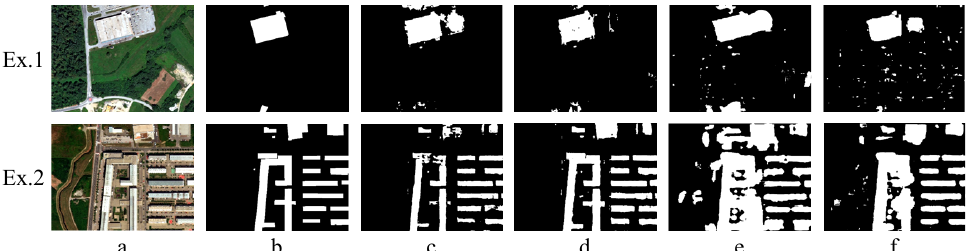
Figure 8. Impact of training set size (RQ1): two examples (Ex. 1, Ex. 2) from GDBX S test set with unseen cities) and the predicted segmentation masks obtained by our models: ( a ) input image; ( b ) ground truth; ( c ) SegNet trained on a small training set; ( d ) SegNet trained on full training data; ( e ) Mask R-CNN trained on a small training set; ( f ) Mask R-CNN trained on full training